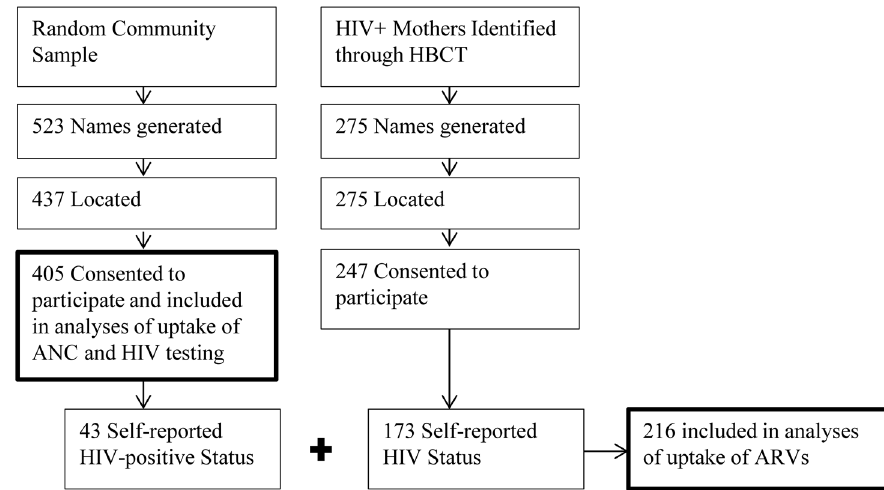
Figure 1. Sampling and Enrollment.